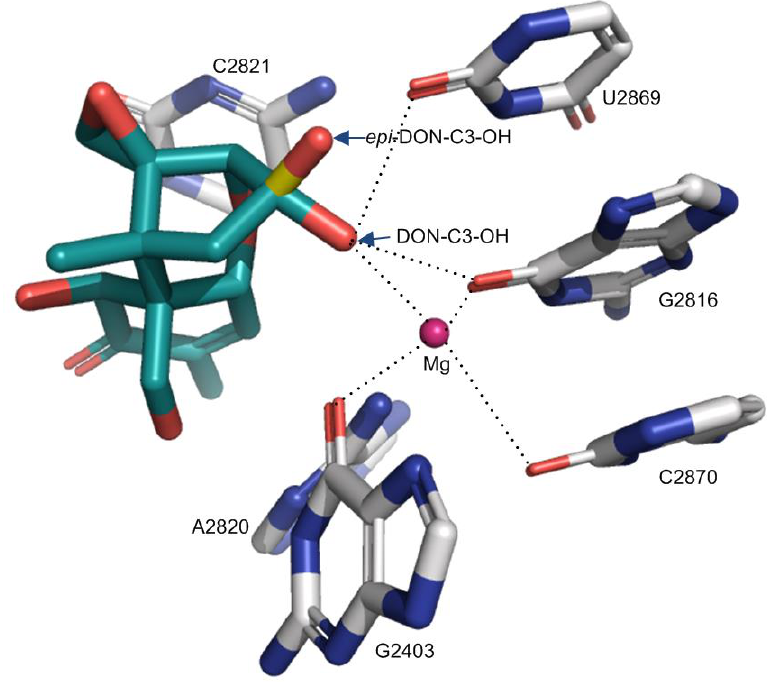
Figure 5. The effect of C 3 -OH conformation change in DON on the interactions to the ribosome. The C 3 -OH in 3-epi-DON was colored in yellow and red. The dotted lines indicate the binding interactions.